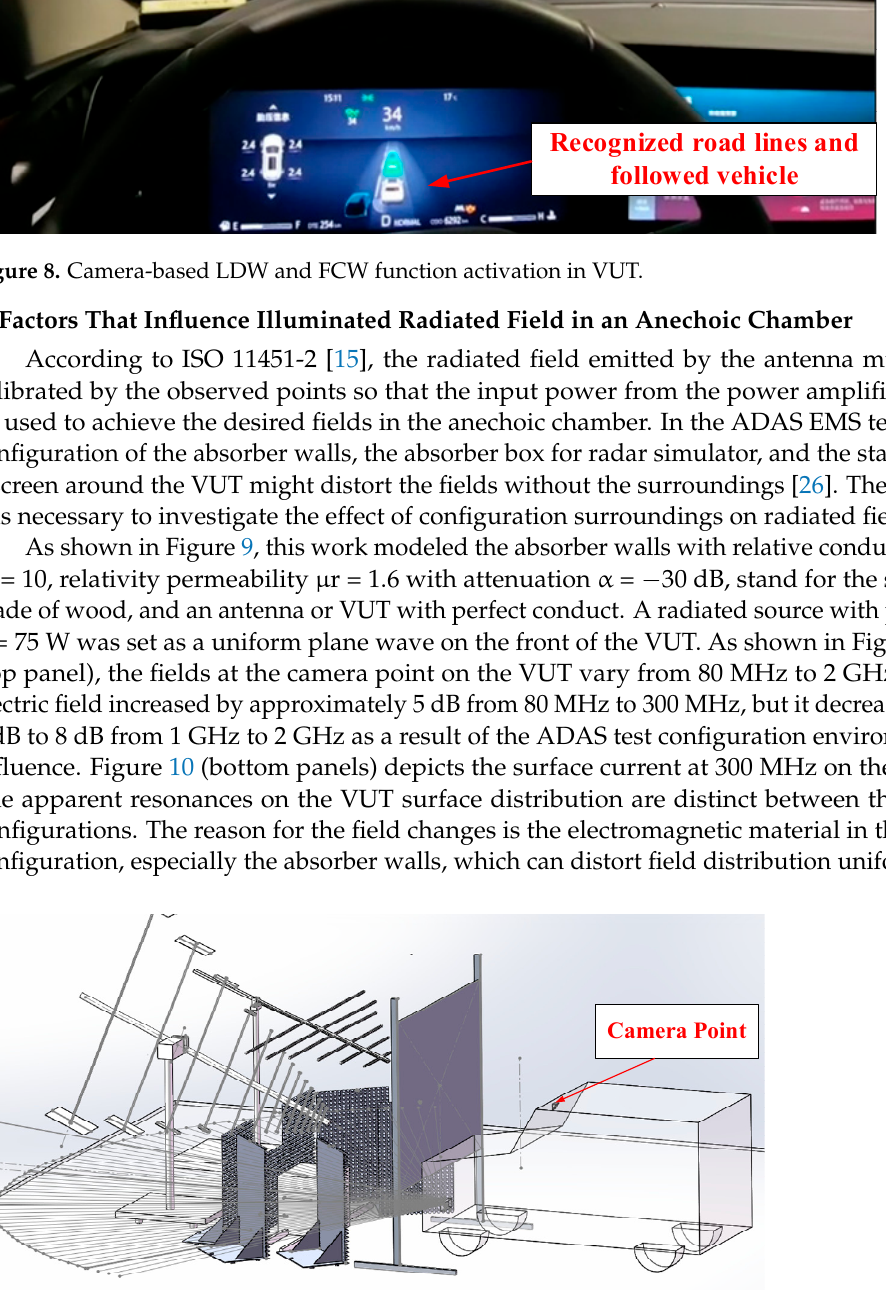
Figure 9. Simulation model of ADAS test configuration in CST.